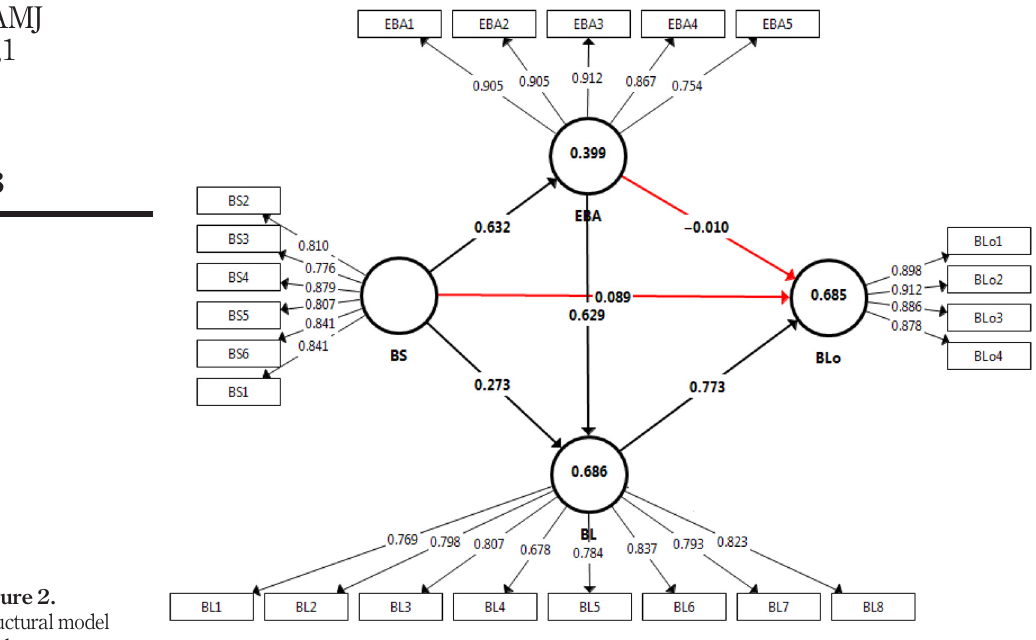
Figure 2. Structural model results